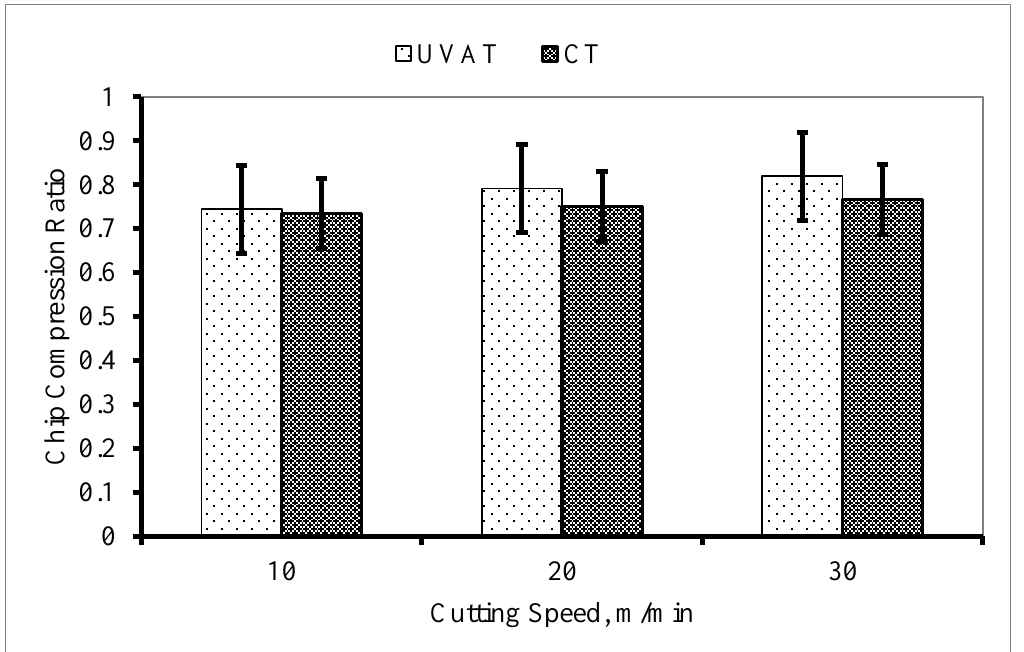
Figure 16. The calculated CCR at DoC = 300 µm.